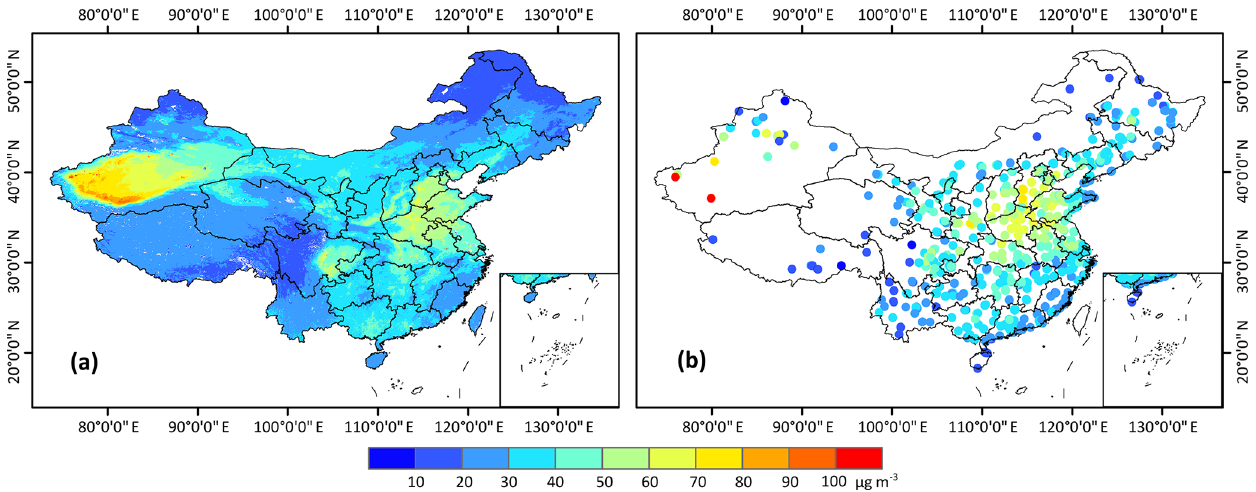
Figure 11. Spatial distributions of annual mean (a) PM 2 . 5 estimates and (b) surface observations in 2018 across